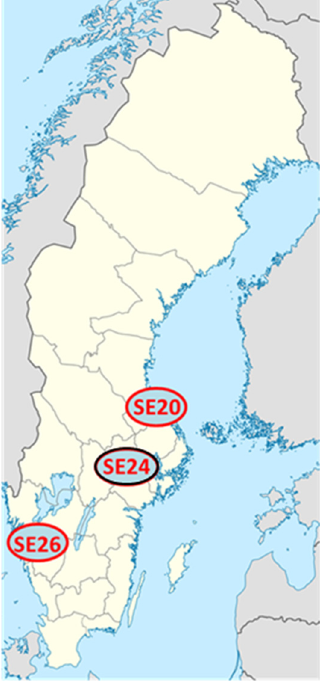
Figure 1. Geographic origin of the sequenced human Ca . N. mikurensis isolates. The sites of residence of the three patients diagnosed with neoehrlichiosis whose blood samples were sequenced are shown. Strain ID SE20 = Gävle, SE24 = Eskilstuna (reference genome, marked in black), SE26 = Kungälv.